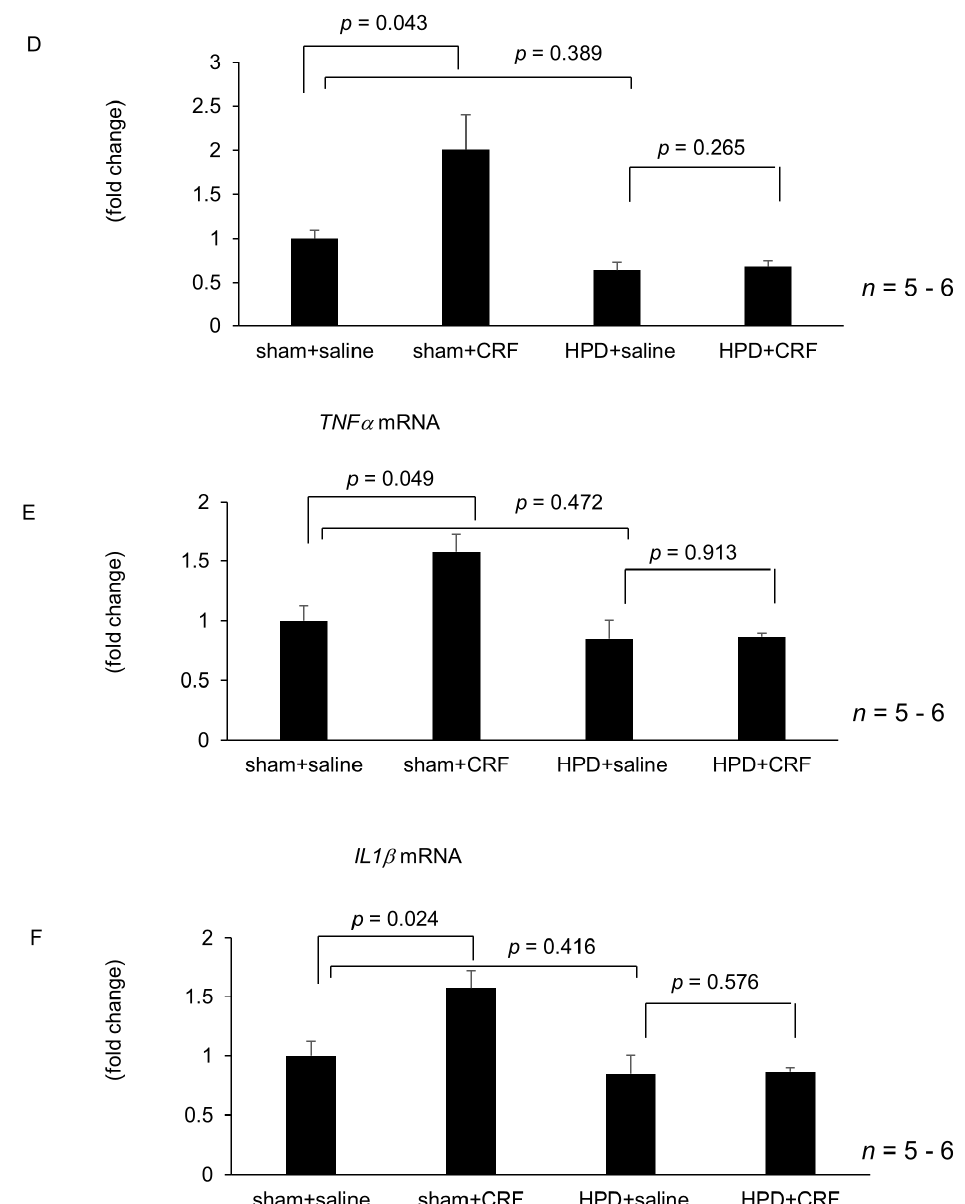
Figure 5. Effect of hepatic branch vagotomy or hepatic plexus denervation (HPD) on intracisternal CRF-mediated hepatic gene expression. The number of each group in rats was six. Hepatic lipid metabolism and inflammation-related gene expression 6 h after intracisternal CRF administration. Relative mRNA expressions of SREBF1 , TNF α , and IL1 β mediated by vagotomy ( A – C ) were evaluated and compared with respective saline control. Relative mRNA expressions of SREBF1 , TNF α , and IL1 β mediated by HPD ( D – F ) were evaluated and compared with respective saline control. Statistical analysis was performed using ANOVA, and data are expressed as means ± standard error (SE). HPD, hepatic plexus denervation.